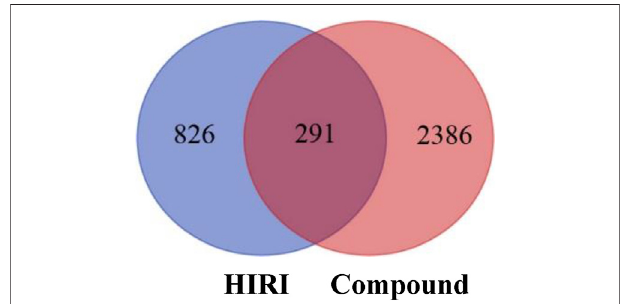
FIGURE 3 | Intersection diagram of components and disease targets. The blue part in the fi gure represents the number of HIRI target genes obtained,thatis,1,117,andtheredpartrepresentsthenumberofconstituent targetgenesobtained,thatis,2,677.Therewere291targetgenesinthe intersection between components and HIRI.